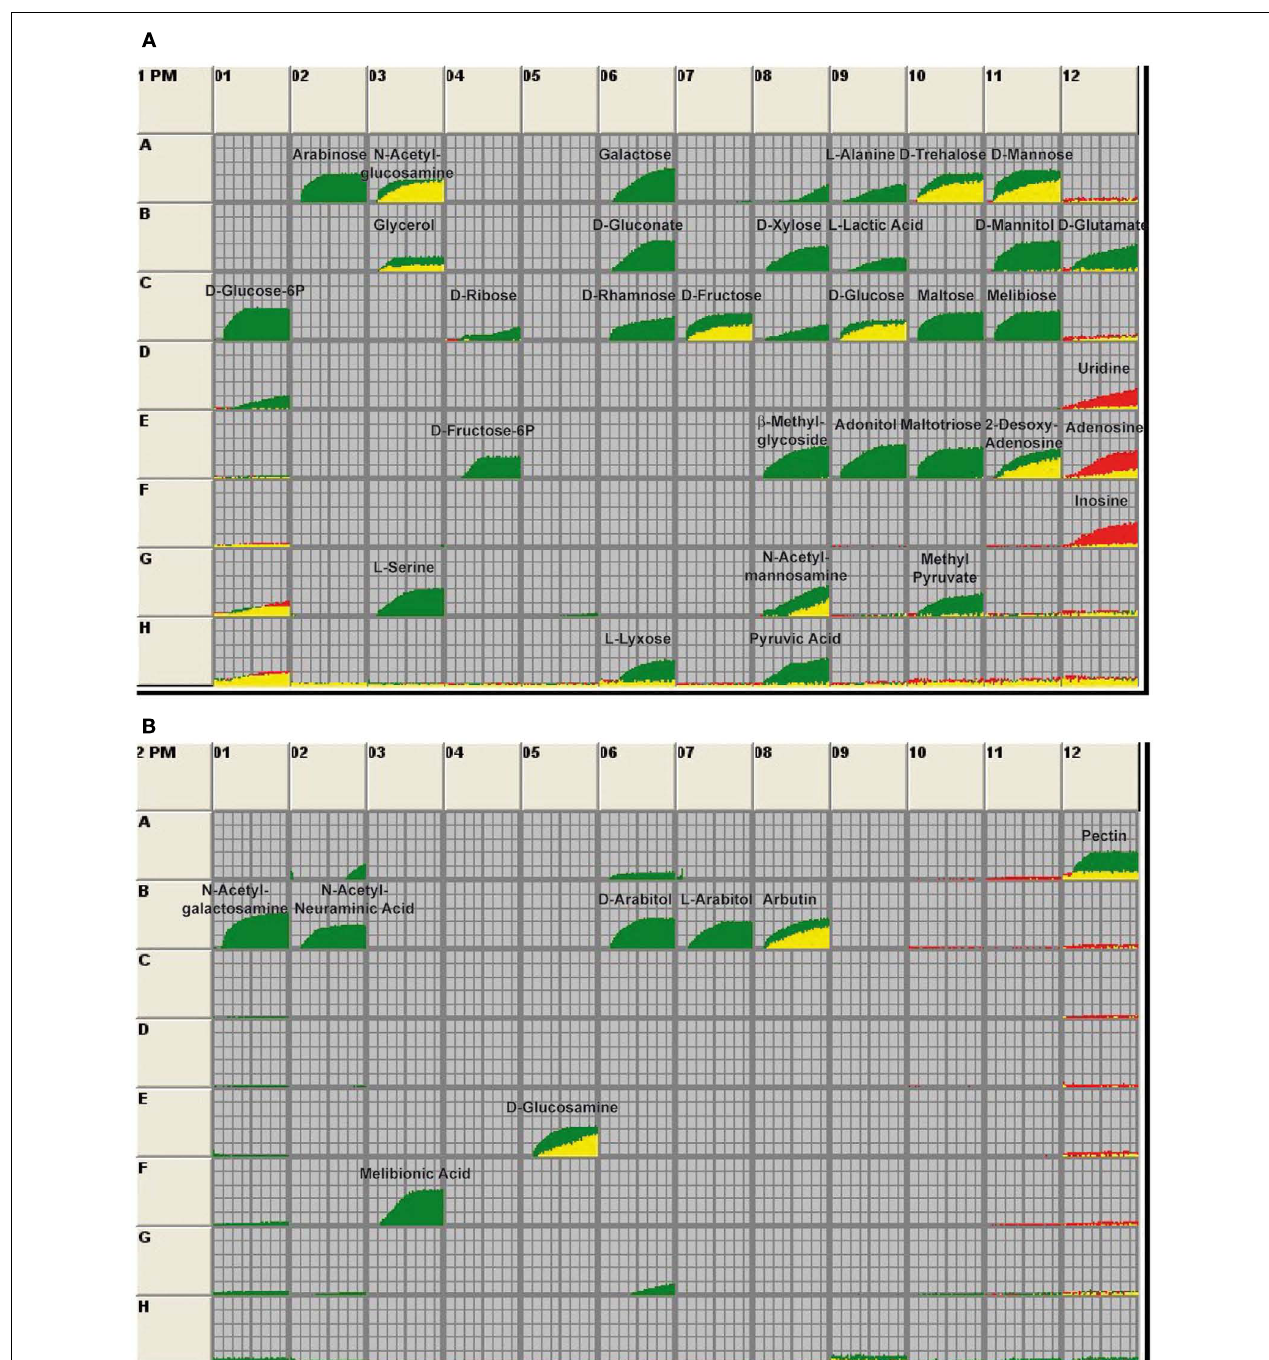
metabolically active. Information about the carbon sources supplied in the wells is given on the manufacturer’s home page (http://www. biolog.com/pdf/pm_lit/PM1-PM10.pdf). Utilization of the metabolites by the wildtype strainYPIII is given by the green areas in the growth curves and use of the carbon sources by the crp mutantYP89 is indicated by the red areas of the growth curves.The data represent one experiment of three independent